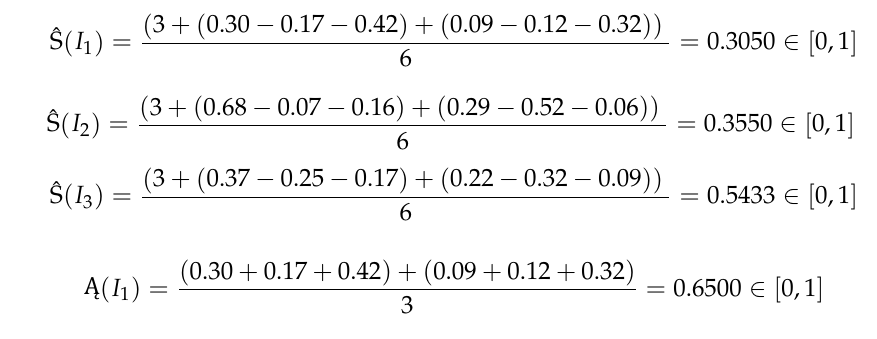
Table 1. Symbols and their meanings. Symbols Meanings Symbols Meanings Ǖ Universal set 𝜙 (cid:3092) Falsity Index of phase term 𝐼̅ Complement of CPFV